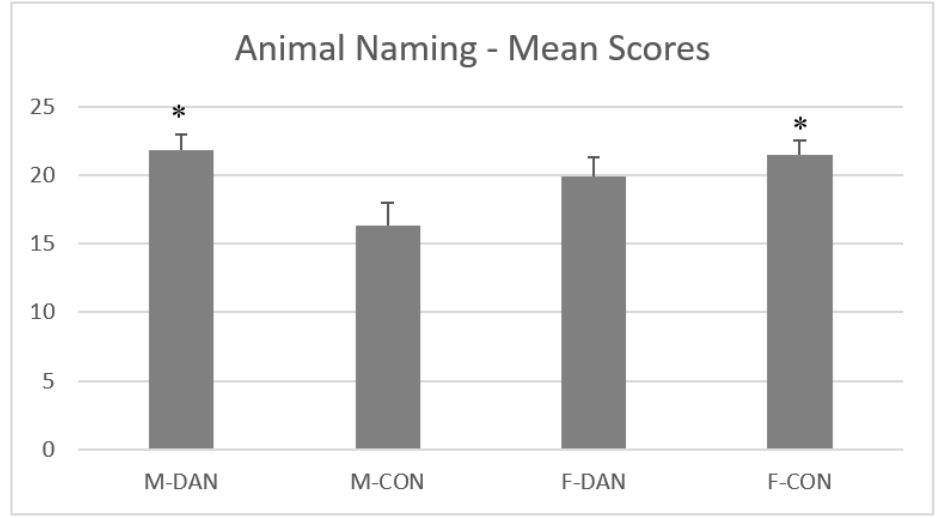
Figure 5. ANIMAL NAMING. Female controls and men in the dancing group scored better than men controls. Male dancing (M-DAN); female dancing (F-DAN); male control (M-CON); female control (F-CON). Mean + SEM. * Significant differences with men controls ( p < 0.05).